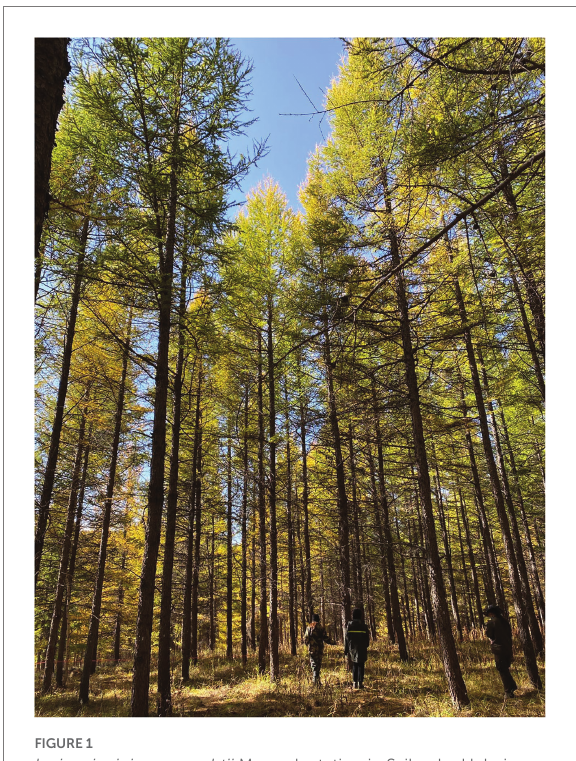
FIGURE 1 Larix principis-rupprechtii Mayr. plantation in Saihanba Hebei